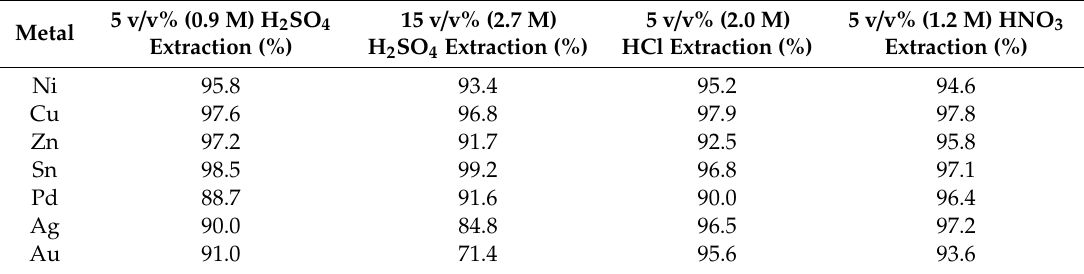
Table 7. Summary of leaching experiment in the presence of inorganic